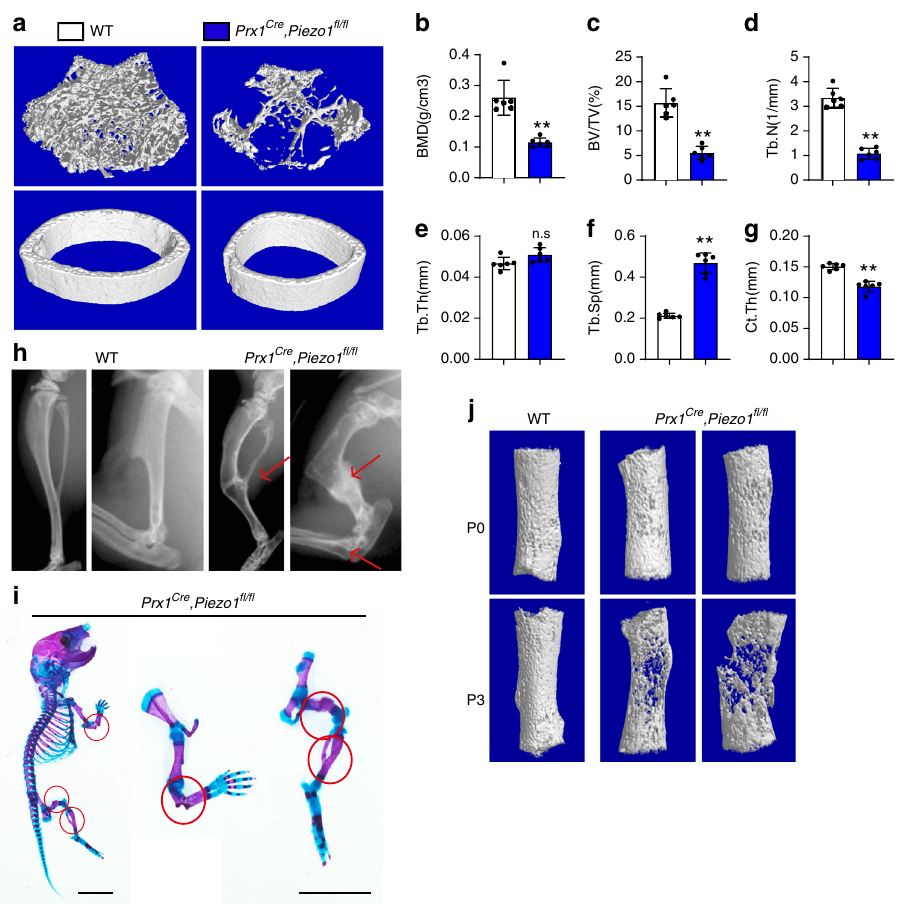
Fig. 1 Loss of Piezo1 in skeletal cells resulted in severe osteoporosis. a 3D μ -CT images of trabecular bones of distal femurs isolated from 6-week-old male WT and Prx1 Cre , Piezo1 fl / fl mice. b – g μ -CT analysis of distal femurs from ( a ) for bone mineral density (BMD) ( b ), bone volume per tissue volume (BV/ TV) ( c ), trabecular number (Tb.N) ( d ), trabecular thickness (Tb.Th) ( e ), trabecular spacing (Tb.Sp) ( f ) and cortical thickness (Ct.Th) of middle shaft of femurs ( g ). * P < 0.05; ** P < 0.01. Two-tailed Student ’ s t test. Data are mean ± SD, n = 6. h X-ray of long bones from 6-week-old male WT and Prx1 Cre , Piezo1 fl / fl mice. Representative images for 3 independent samples. i Whole mount skeleton staining of 3-day-old WT and Prx1 Cre , Piezo1 fl / fl mice by Alcian blue and Alizarin red S. Scale bar = 5 mm. j 3D μ -CT images of femurs isolated from 0-day-old and 3-day-old WT and Prx1 Cre , Piezo1 fl / fl mice. Source data are provided in the Source Data